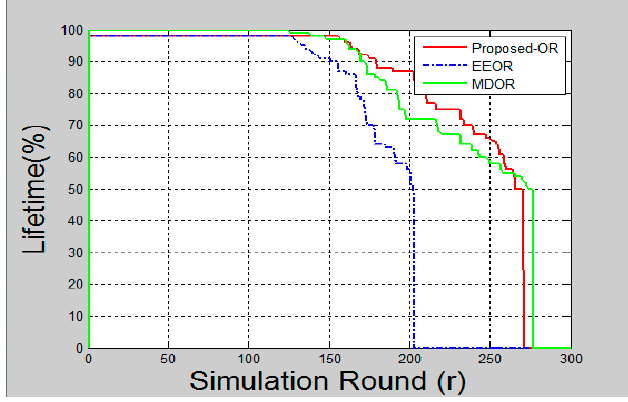
Figure 8. Network lifetime.